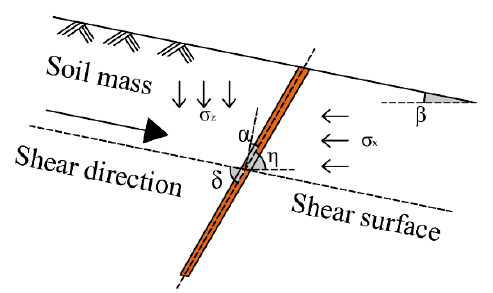
η α η α and angles of roots when the shear direction is incon- and angles of roots when the shear direction is incon-